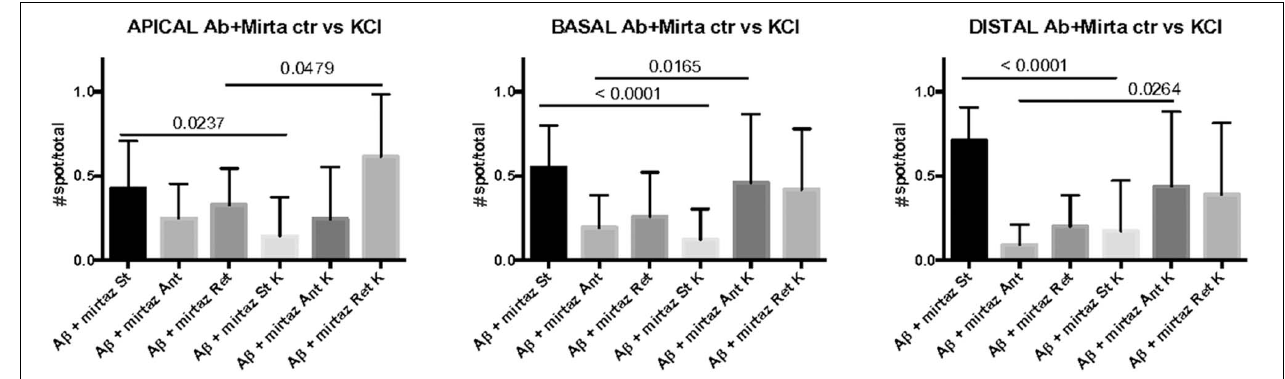
FIGURE 6 | Comparison of number of pGOLT spots in control conditions and after high K + treatment. The same hippocampal neurons were treated with A β + mirtazapine and recorded in time lapse before and after entering depolarizing conditions (K+, KCl, 50 mM, 10 min). The histograms represent the occurrence of